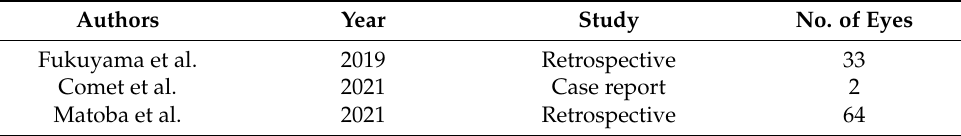
Table 3. En face OCT.